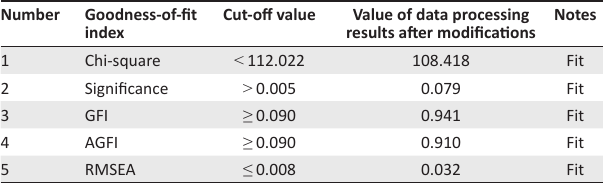
TABLE 2: Goodness-of-fit test results for the modified confirmatory